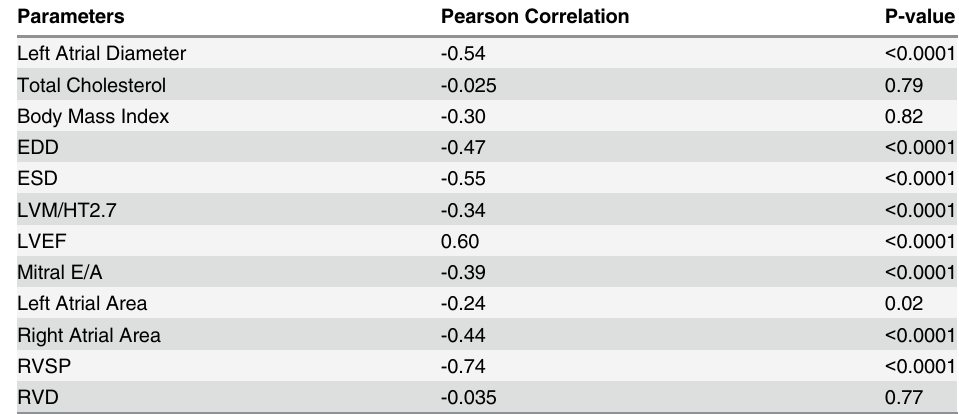
fraction and transmitral E/A ratio correlated significantly with TAPSE. Independent Predictors of RV Systolic Dysfunction Table 4 shows that the Independent predictors of RV systolic dysfunction are poor LV function and increased right atrial area. Table 3. Relationship between RV Function and Echocardiography and Laboratory Parameters.